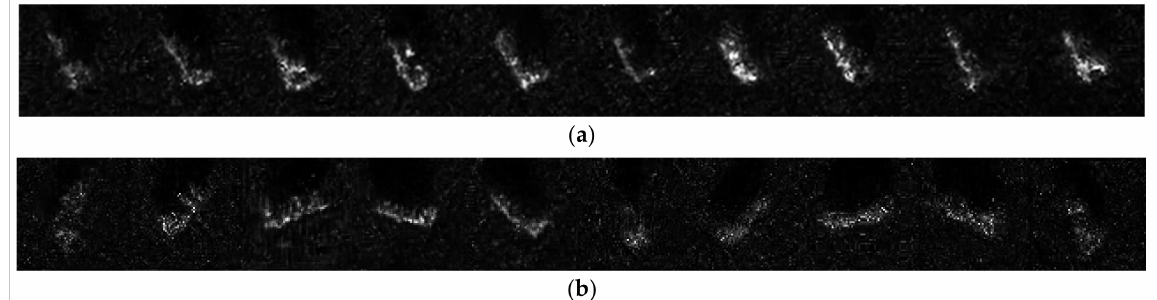
Figure 11. The generated SAR images with varying two variables, target classes, and pose angles: ( a ) fixed pose angle 151.2 ◦ and varying 10 target classes; ( b ) fixed target class “BTR70” and varying 10 pose angles from 0 ◦ to 324 ◦ uniformly by a pose angle increment of 36 ◦